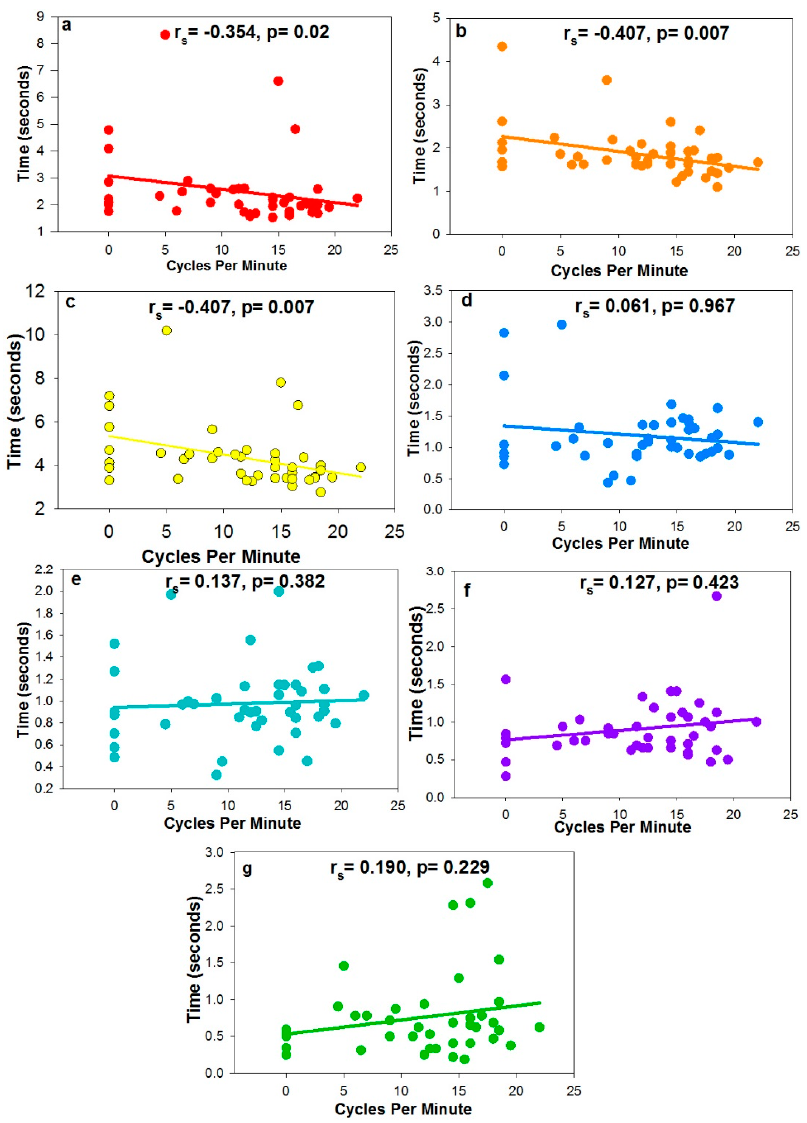
Figure 6. The correlation coefficient between AF and ( a ) Time for Accommodation, ( b ) Time for Disaccommodation, ( c ) Objective Time for Accommodative Change, ( d ) Novel Latency of Accommodation, ( e ) Novel Lactency of Disaccommodation, ( f ) Previously used Latency of Accommodation, and ( g ) Previously used Latency of Disaccommodation.